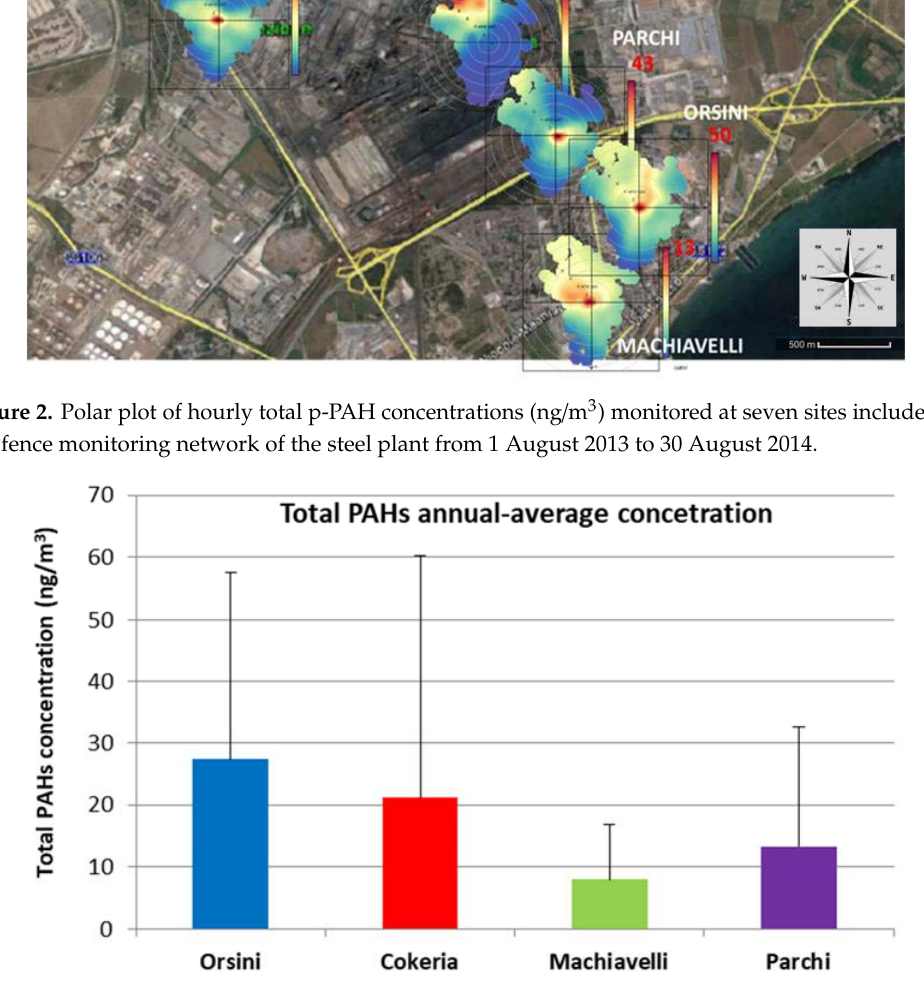
Figure 2. Polar plot of hourly total p ‐ PAH concentrations (ng/m 3 ) monitored at seven sites included